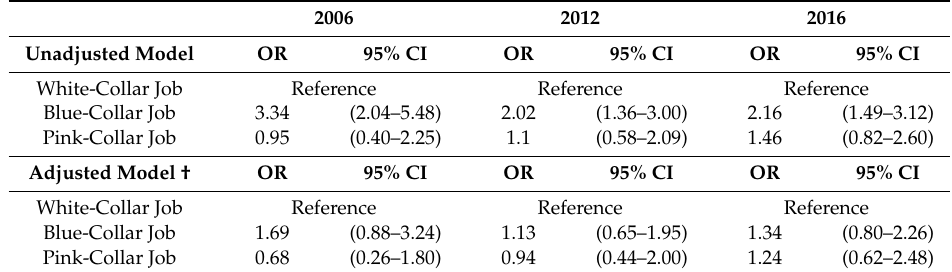
Table 2. The odds ratios (ORs) of cognitive impairment (MMSE < 24) in male elderly over 10 years (2006, 2012, and 2016).